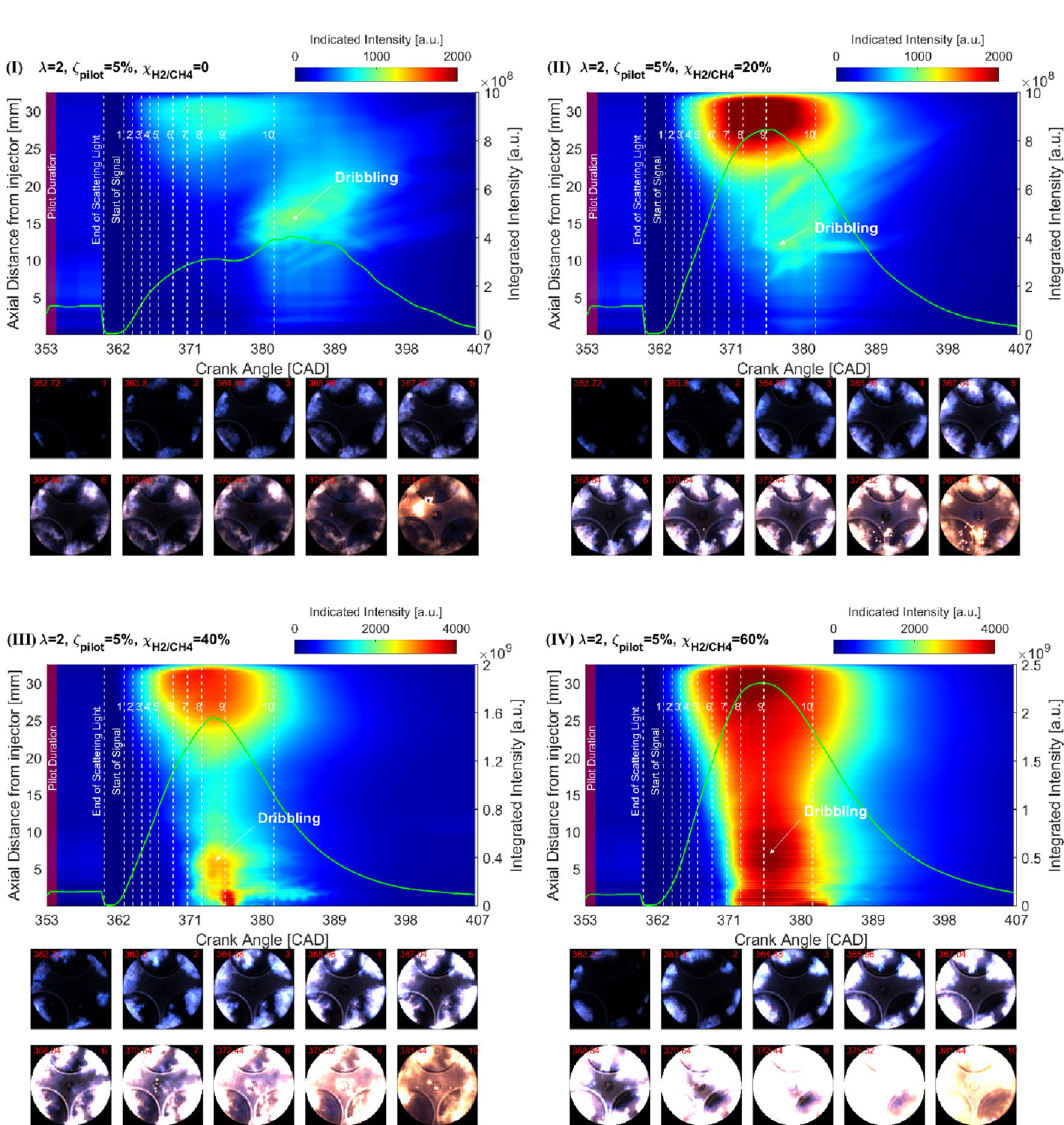
Figure 9. The true-color natural flame luminosity (bottom) and axial intensity distribution (upper) of TF combustion with different H 2 concentrations, ( I ) χ H 2 / CH 4 = 0, ( II ) χ H 2 / CH 4 = 20%, ( III ) χ H 2 / CH 4 = 40%, ( IV ) χ